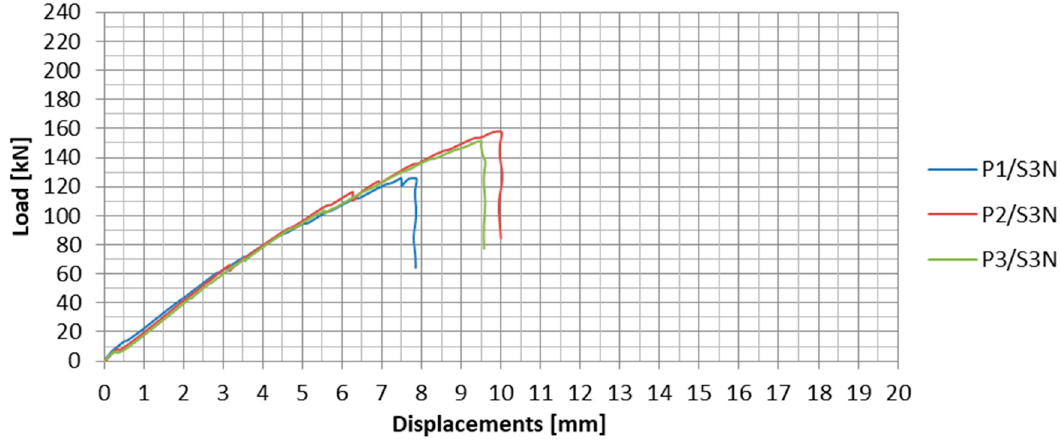
Figure 16. Load-displacement plots for all the specimens in the S3N series. Table 6. Test results of the specimens tested in S3N